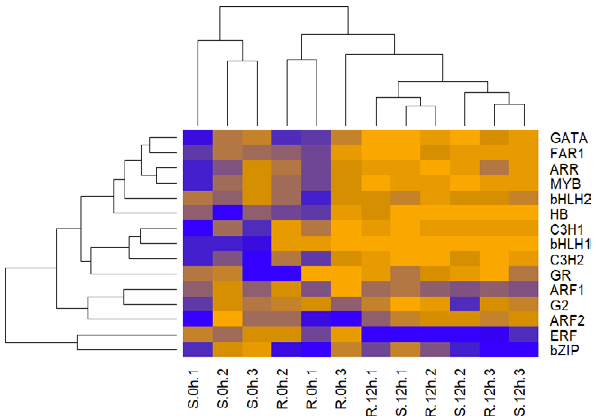
Figure 4. Hierarchical clustering analysis of the top 15 differentially expressed genes among the susceptible and resistant samples.